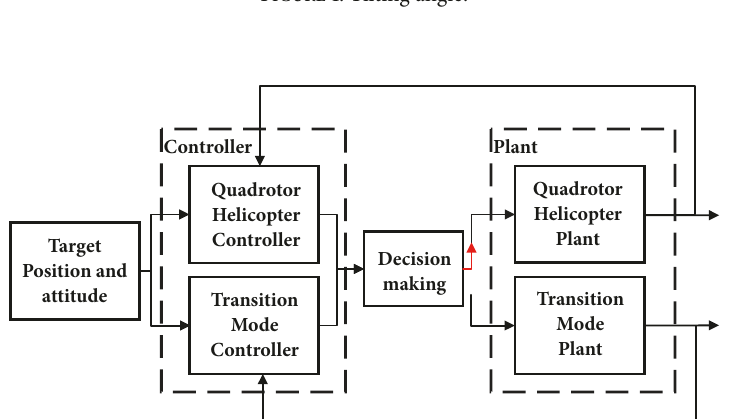
Figure 1: Tilting angle.